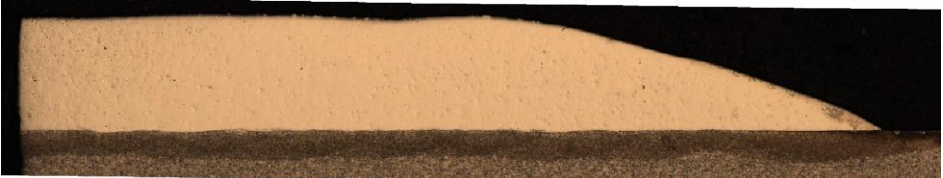
Figure 4. Macrostructure of INCONEL 625 coating cladded on 16Mo3 steel tube, average thickness 2.2 mm (×25).